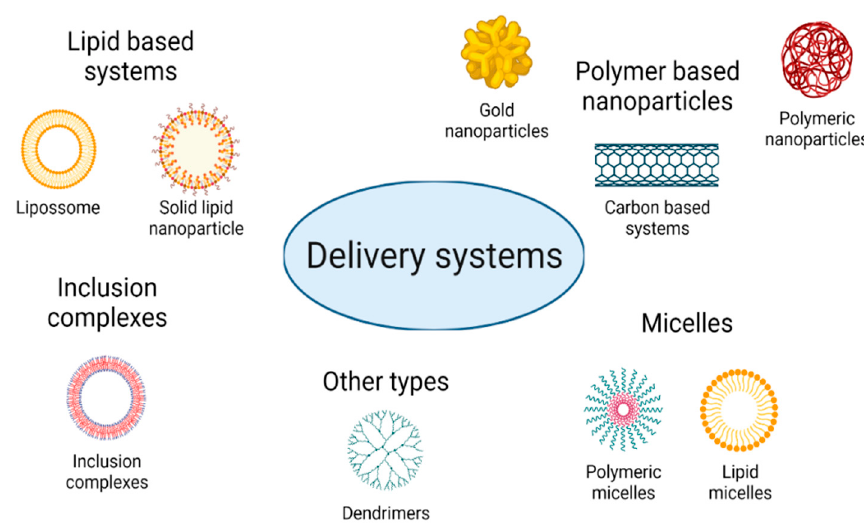
Figure 6. The main types of delivery systems explored for drug encapsulation. The characteristics of each type of system and the compounds that constitute them can be analyzed in the topics below. Table 1 summarizes the delivery systems and also indicates the ones already developed for cervical cancer therapies in in vitro (Hela cells) and in vivo assays (U14 cervical